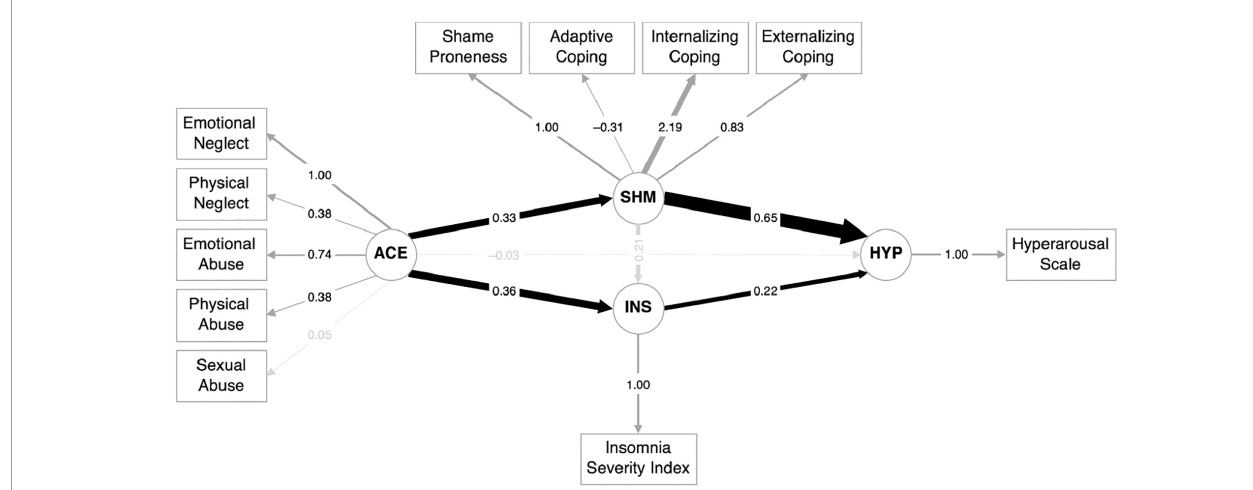
FIGURE2 Structural equation model for